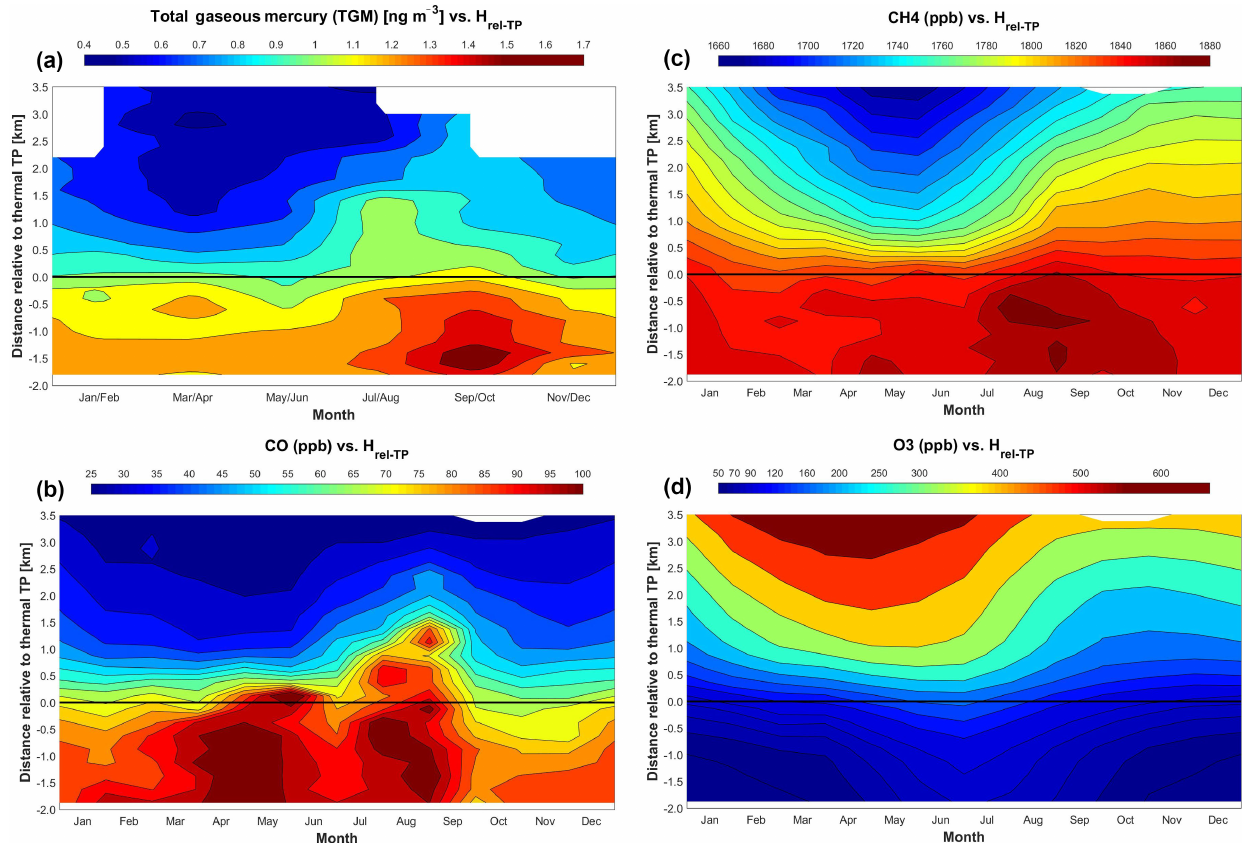
Figure 4. Seasonal variation of mean TM concentrations (a) , CO (b) , CH 4 (c) and O 3 (d) mixing ratios in distance relative to the thermal tropopause derived from ozone soundings according to Sprung and Zahn (2010). All TM data north of 20 ◦ N obtained between April 2014 and February 2016 were considered for this plot (2288 individual data